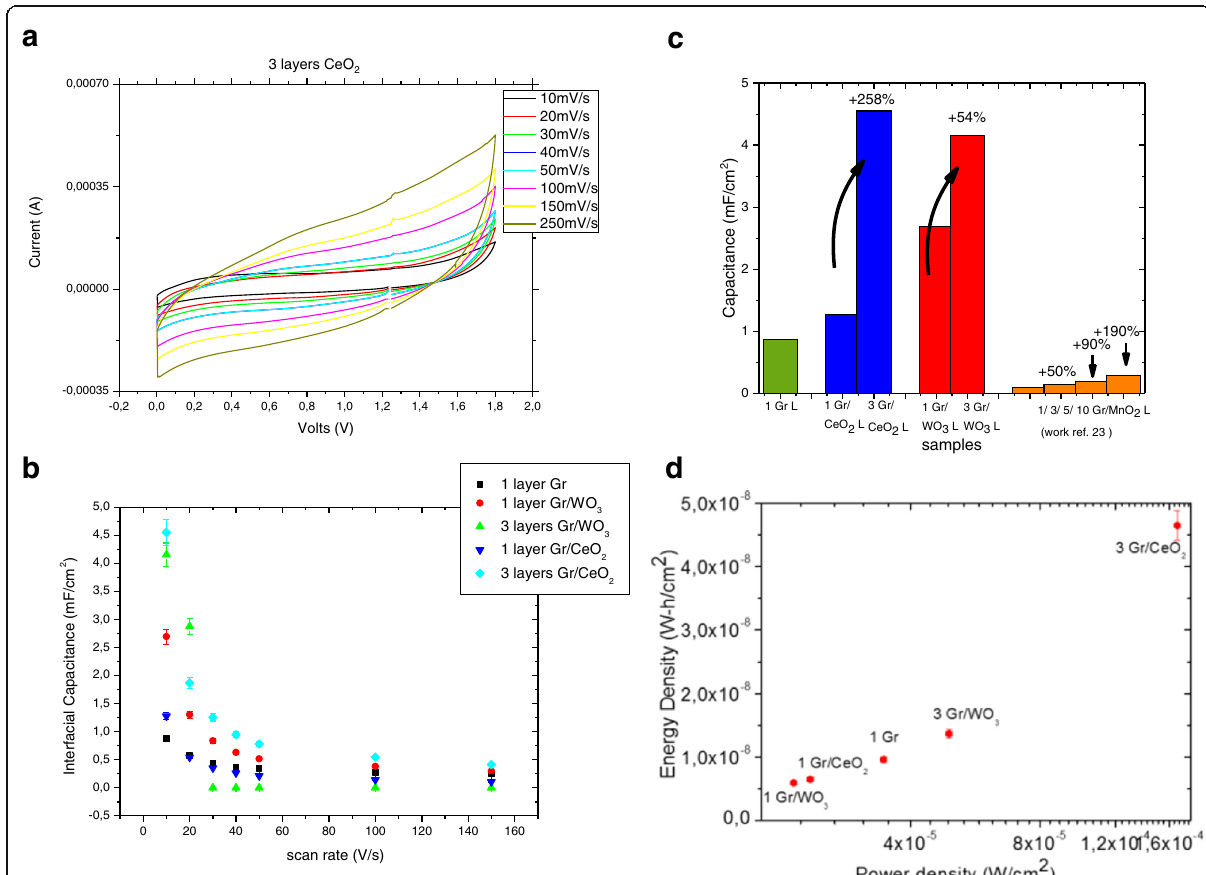
Fig. 4 Electrochemical characterization. Detailed legend: a CV measurements of the cell consisted of electrodes with three layers of graphene/ CeO 2 particles each, at different scan rates. b Interfacial capacitance of the different hybrid electrodes at different scan rates. All devices present the higher capacitance at the lower scan rates. c Histogram with the percentage increase of capacitance with respect to number of layers. d Ragone plot demonstrating the overall performance of the graphene-based